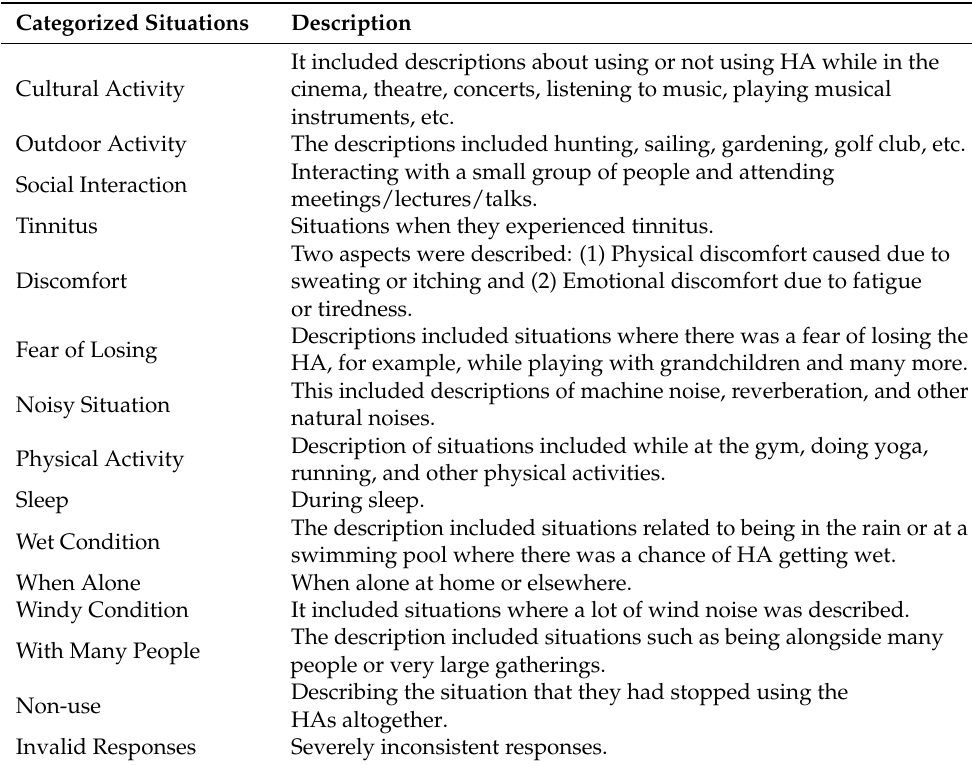
Table 1. The labeled categories derived from the theme analysis of the free-hand text responses to the “Other” category in the